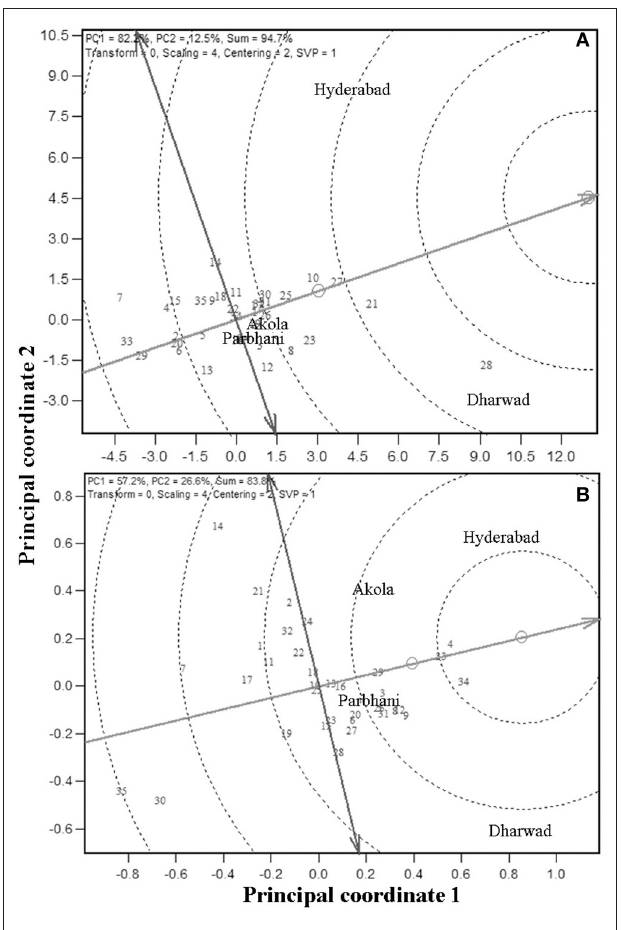
FIGURE 3 | Ranking of 35 genotypes relative to ideal genotype [the small circle on average environment coordinate, average environment coordination (AEC)] for GY (A) and GMS (B) .